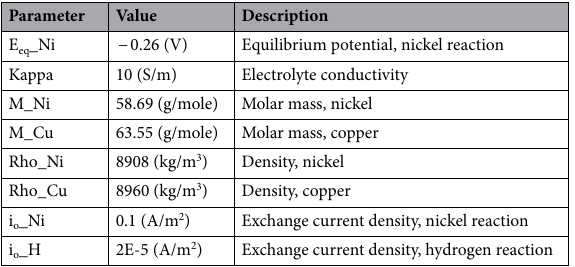
Table 4. The electrolyte initial condition and parameters of Ni electroplating model.